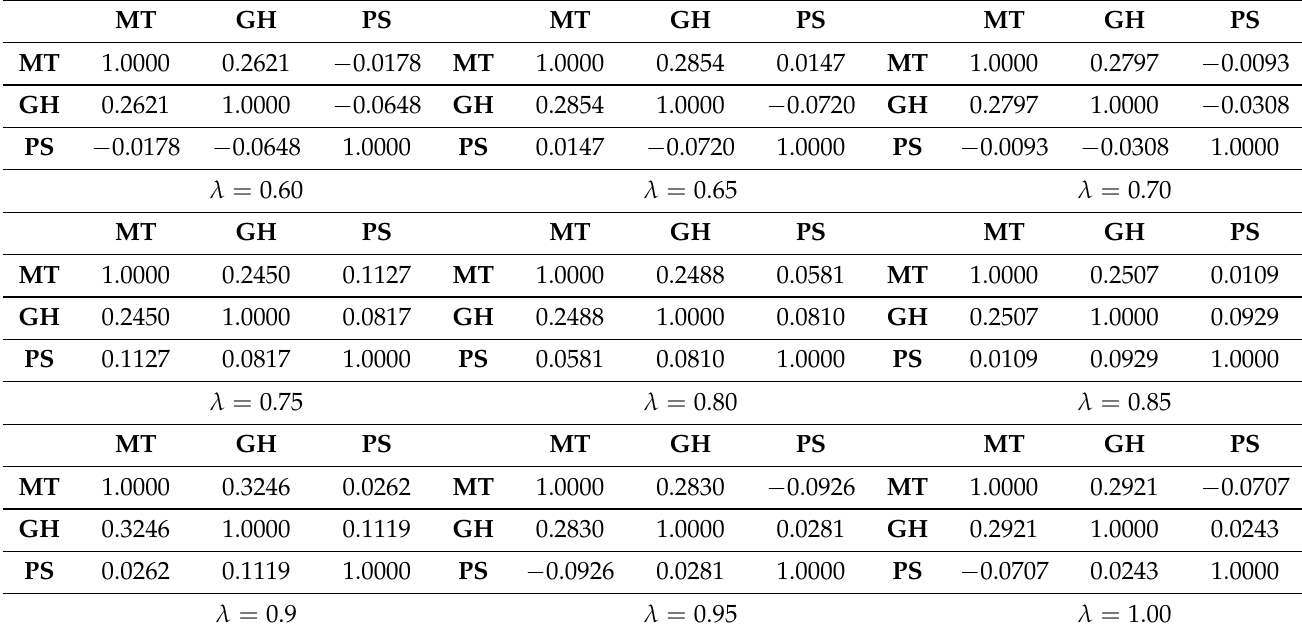
Table 3. Correlation matrices for anomalous days for different λ ’s and θ =